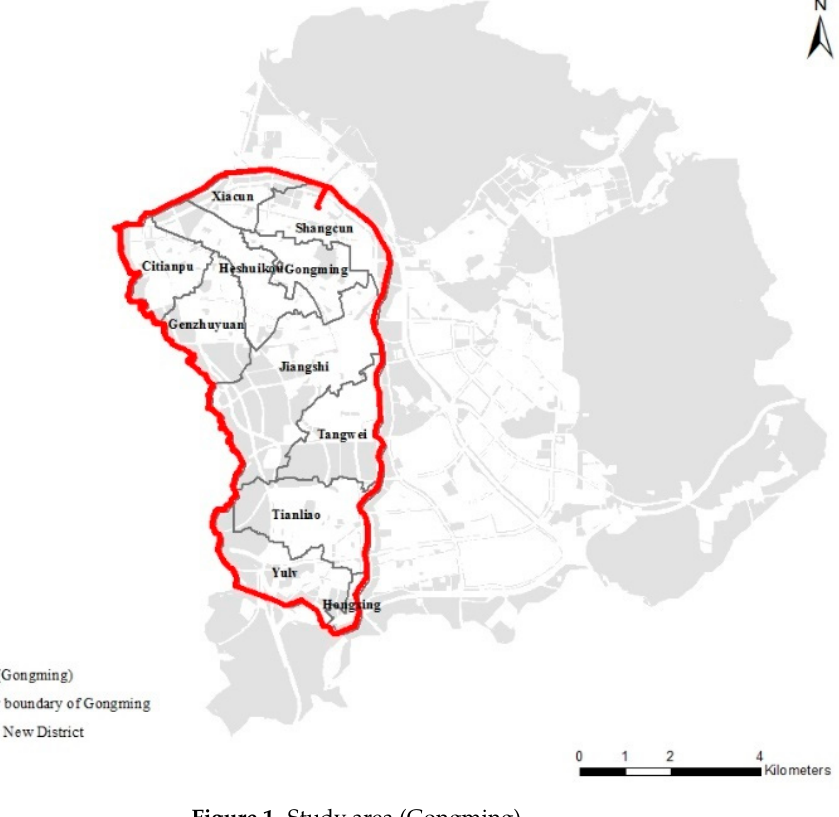
Figure 1. Study area (Gongming).